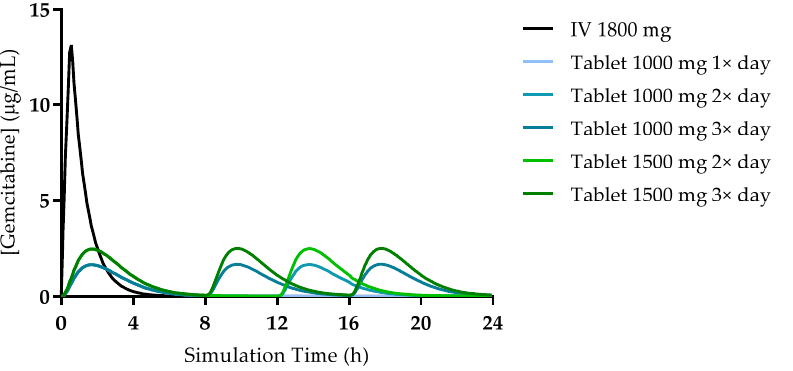
Figure 4. Plasma concentration—time profiles for gemcitabine following 30 min IV infusion and different oral (tablet) treatment regimens.